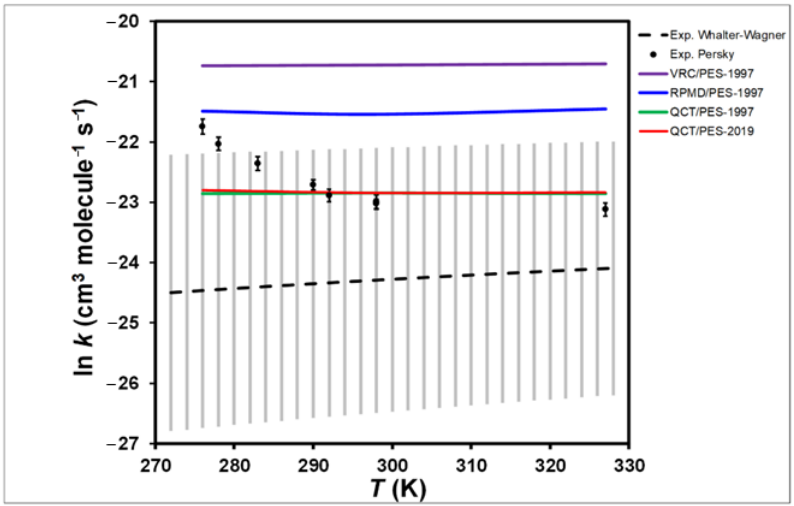
Figure 4. Arrhenius plots the rate constants (cm 3 molecule − 1 s − 1 ) for the F( 2 P) + NH 3 reaction using different kinetics methods and PESs together with experimental values for comparison. See text for acronyms.